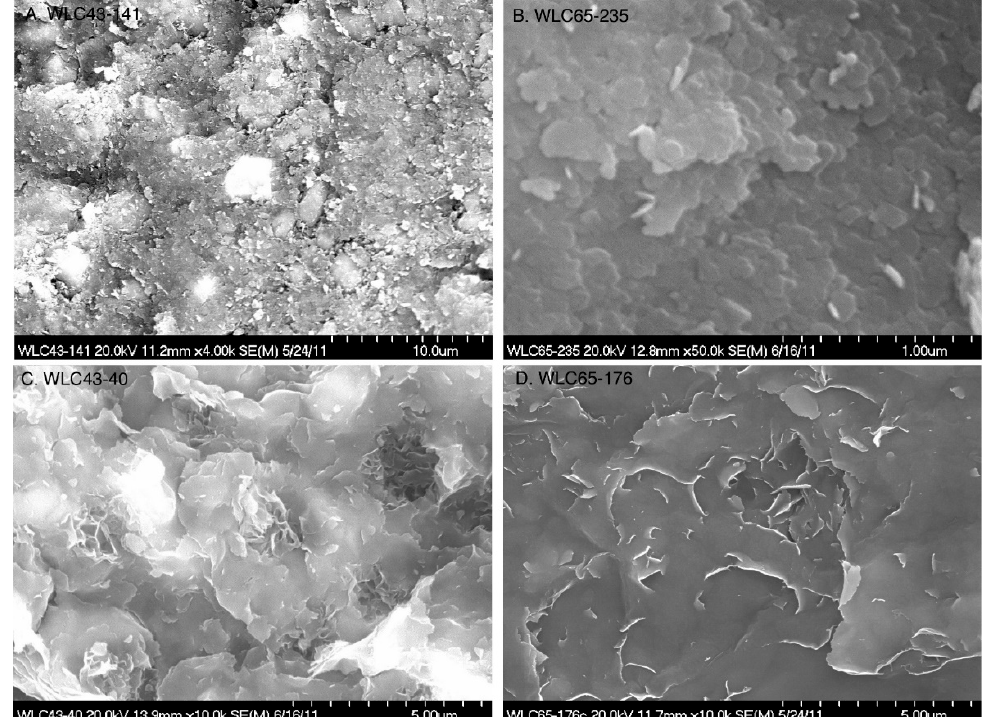
Figure 10. Secondary scanning electron microscope images. ( A ) Fine illite grains with larger K-feldspar anhedra and bright pyrite cubes from sample WLC43-141.1 feet (43 m). Horizontal field of view = 30 µm. From interval with 6920 ppm Li. ( B ) High magnification image of illitic clay, showing pseudohexagonal plate morphology from sample WLC65-235 feet (72 m). Horizontal field of view = 2.5 µm. From interval with 6380 ppm Li. ( C ) Smectite with pyrite (bright) from sample WLC43-40 feet (12 m). Horizontal field of view = 12 µm. From interval with 2590 ppm Li. ( D ) Smectite(?) clay from the transitional (mixed) clay zone sample WLC65-176.6 feet (54 m). Horizontal field of view = 12 µm. From interval with 3690 ppm Li.